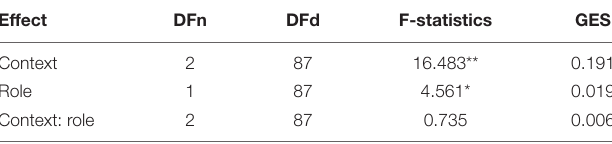
Table 2 | Attitudes toward unethical behavior: two-way Mixed ANOVA.